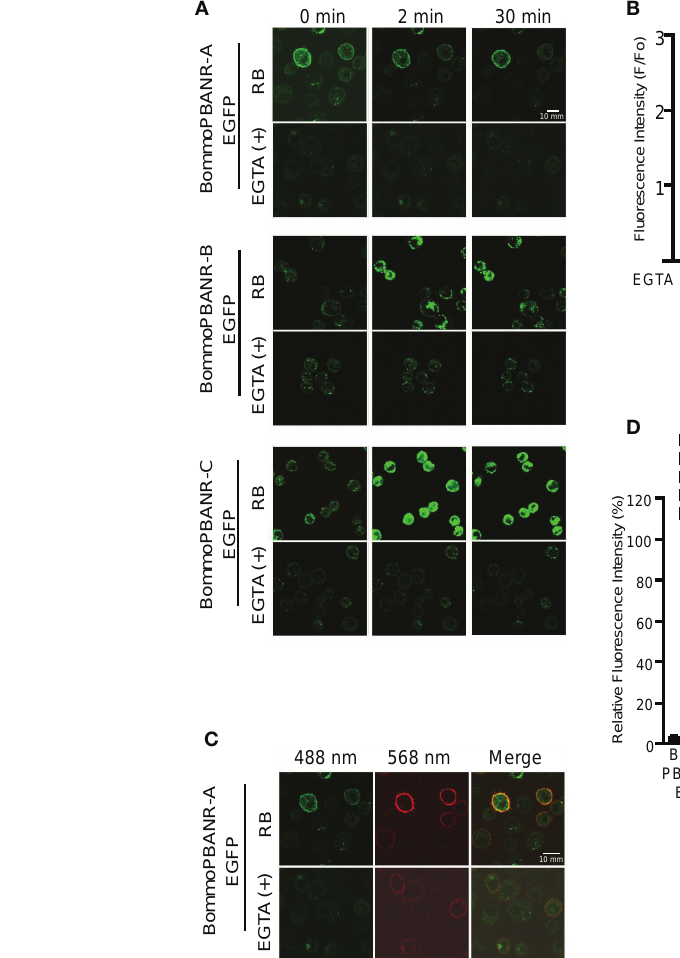
of BommoPBANR-A–EGFP cells incubated with RR-C10PBAN R2K (50nM) in the presence and absence of extracellular Ca 2 + . Co-localization is indicated by yellow in the merged images. (D) . Dose–response profile of BommoPBANR cell lines to increasing concentrations (1nM–10 μ M) of C10PBAN R2K . Fluorescence intensity was measured on a FV1000D confocal laser scanning microscope using Fura Red as the Ca 2 + indicator.The fluorescence intensity is presented relative to BommoPBANR-C–EGFP activation with 100nM C10PBAN R2K . Bars represent mean values + SEM of five replicates per peptide concentration. Different letters denote a statistically significant difference for each sample (one-way ANOVA, p <